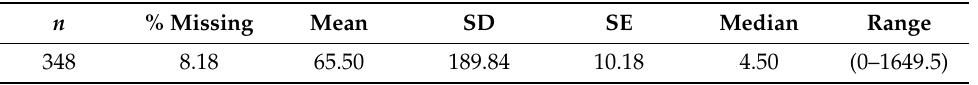
Table 4. Descriptive statistics of the frequency of posts (SD, Standard Deviation; SE, Standard Error).